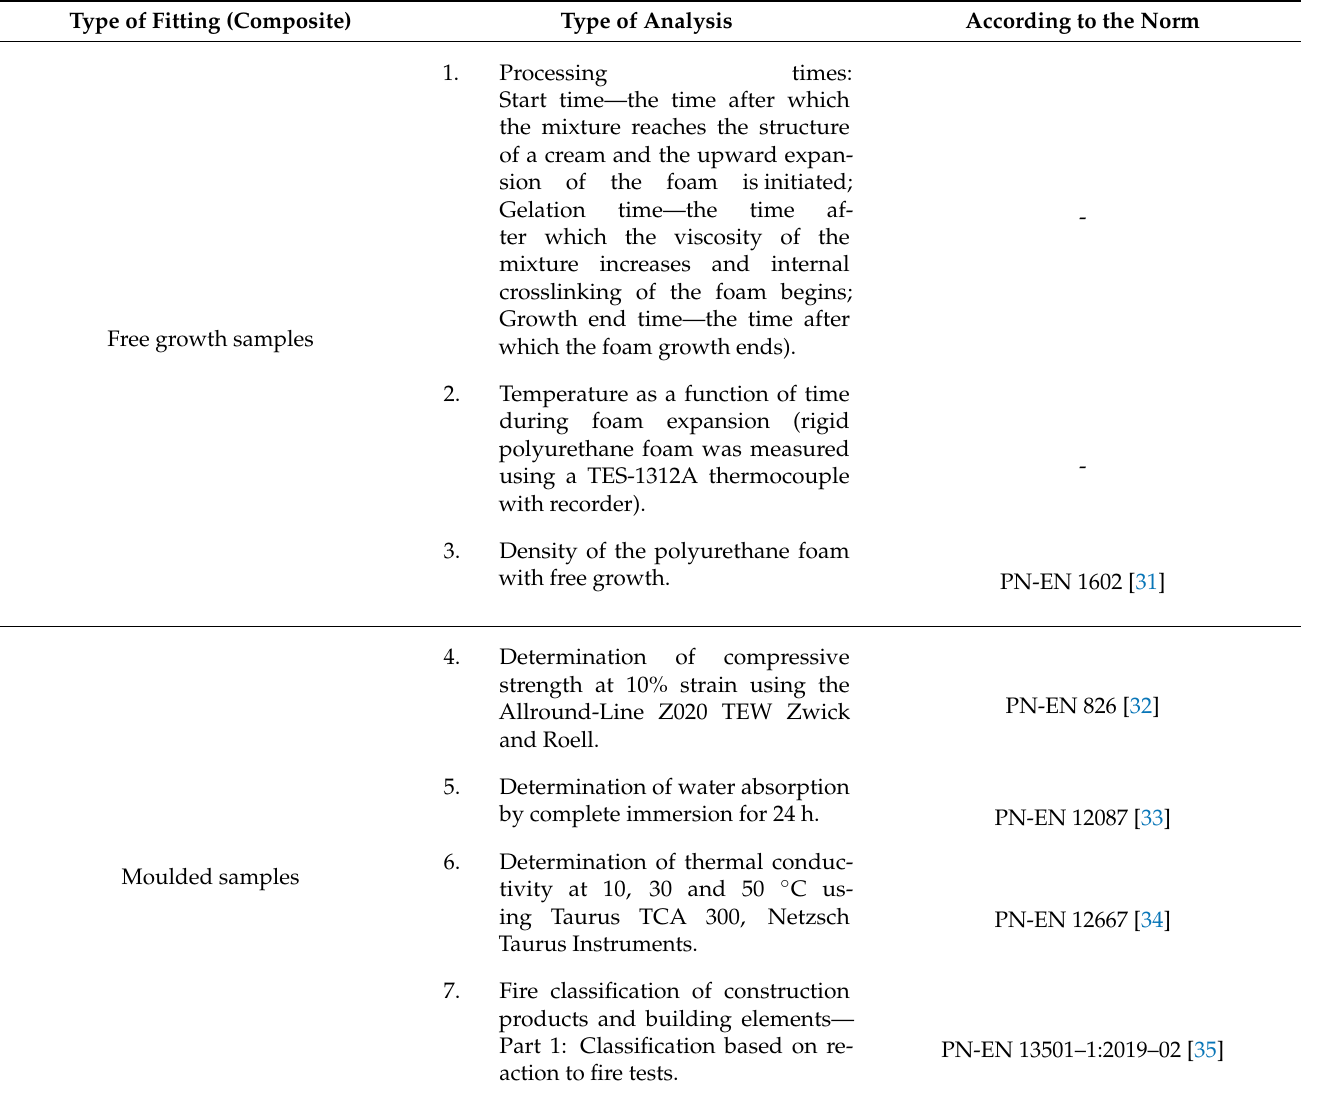
Table 2. Conducted analyses of polyurethane